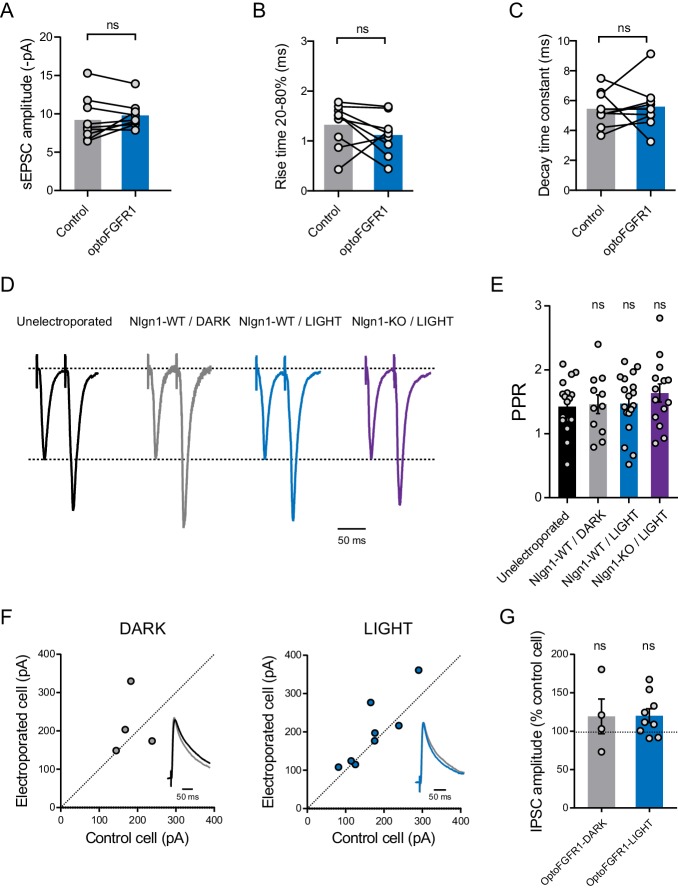
Stimulation of optoFGFR1 does not affect spontaneous AMPAR-mediated EPSC amplitude or kinetics, paired pulse ratio (PPR), or inhibitory currents in CA1 neurons.(A–C) Quantification of AMPAR-mediated sEPSC amplitude, rise time, and decay time, respectively, for control neurons (grey boxes) and neurons expressing optoFGFR1 (blue boxes). Data were compared using the paired t-test (A,B) or the Wilcoxon matched-pairs signed rank test (C) (ns: not significant). (D) Average EPSC traces in response to paired stimuli (50 ms interstimulus interval) recorded from an unelectroporated WT neuron (in black), WT neurons expressing optoFGFR1 kept in the dark (in grey) or exposed to light (in blue) and a Nlgn1-KO neuron expressing optoFGFR1 and exposed to light (in violet). (E) Average PPR for the same conditions as in (A) (Wilcoxon matched-pairs signed rank test, ns: not significant). Data represent mean ± SE. (F) Scatter plots of IPSCs in optoFGFR1-expressing neurons versus paired unelectroporated neurons (control cell), in the dark (black) and light (blue) and conditions, respectively. Representative IPSCs traces (black or blue) were recorded at a holding potential of +10 mV, normalized to control (grey), and are shown as insets. (G) Average amplitude of IPSCs in the two conditions, normalized to the control (100%). Data were compared to the control condition by the Wilcoxon matched-pairs signed rank test (ns, not significant).